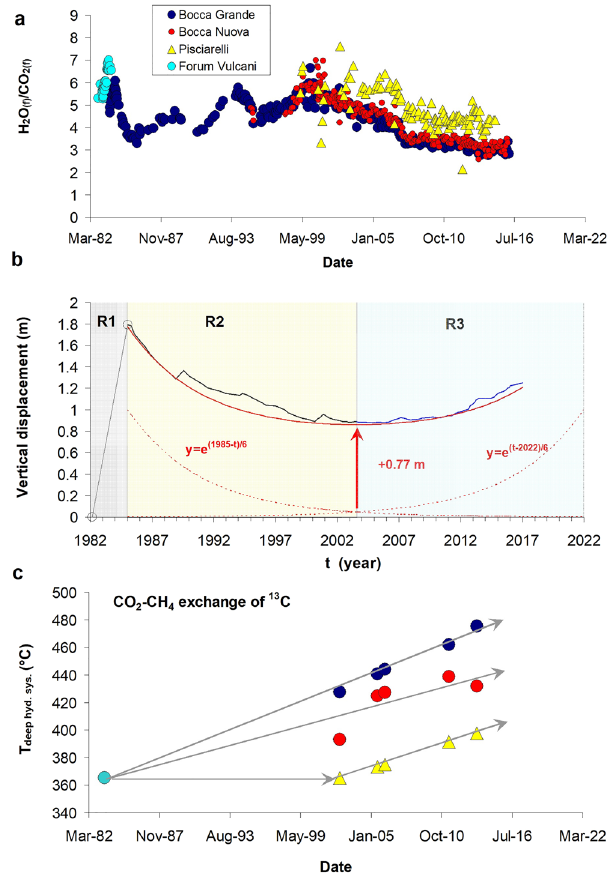
Figure 2. Major geochemical and ground deformation features since 1982. ( a ) Chronogram of H 2 O/CO 2 (molar ratio) at Solfatara (Forum Vulcani, Bocca Grande and Bocca Nuova vents) and Pisciarelli fumaroles (Supplementary Data and refs 15,22–25 ). ( b ) Baseline displacement (red-solid line) involving the post-1984 subsidence and the ongoing unrest (the zero is set at the beginning of the 1982-84 uplift). Error bars on measured displacements are ± 4 mm for leveling (until year 2000; ref. 19 ) and ± 3 mm for continuous GPS (after year 2000; from INGV-OV surveillance bulletins: http://www.ov.ingv.it/ov/en/campi-flegrei/275.html). Three deformation regions are distinguished (R1, R2 and R3). ( c ) Chronogram of CO 2 -CH 4 isotopic temperatures at the hydrothermal bottom (see Methods and Table 1). Heating trends (grey arrows) show the drying of the hydrothermal